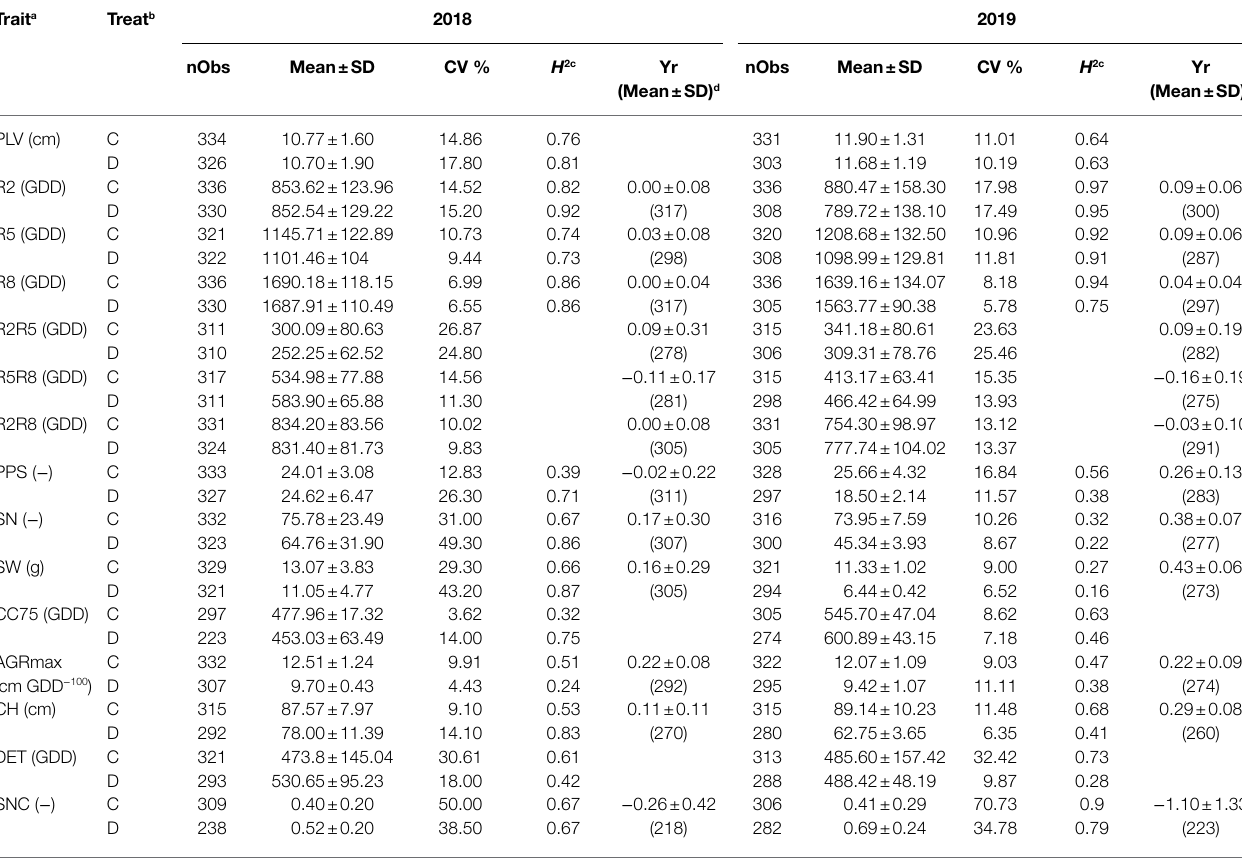
TABLE 2 | Summary statistics of BLUP values from control and drought fields in 2018 and 2019. Trait a Treat